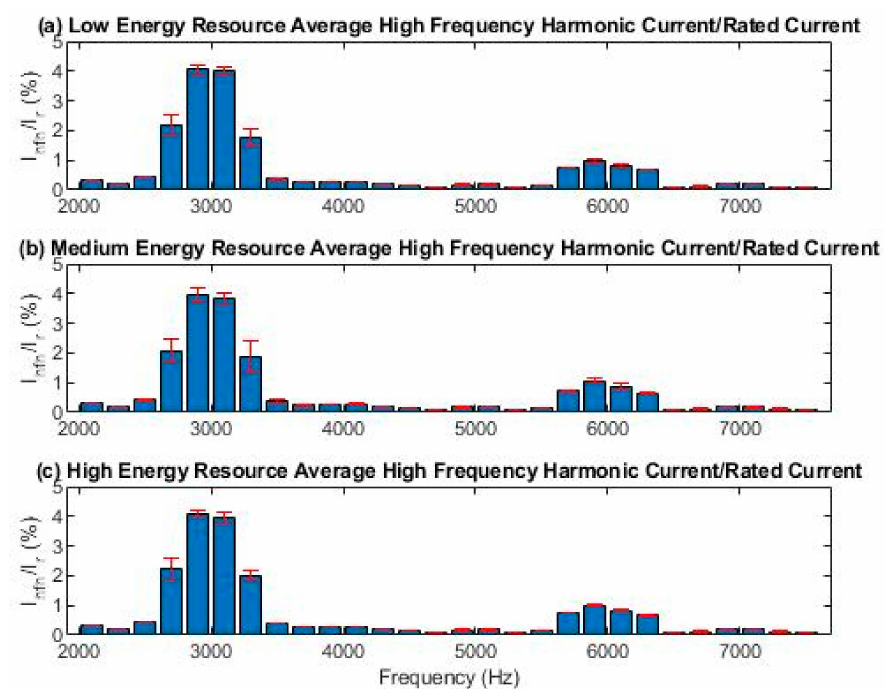
Figure 10. Sea trial average ratios of high-frequency harmonic current amplitude to rated current for ( a ) low energy, ( b ) medium energy, and ( c ) high energy resource classifications, including error bars, which represent the standard deviation of the data